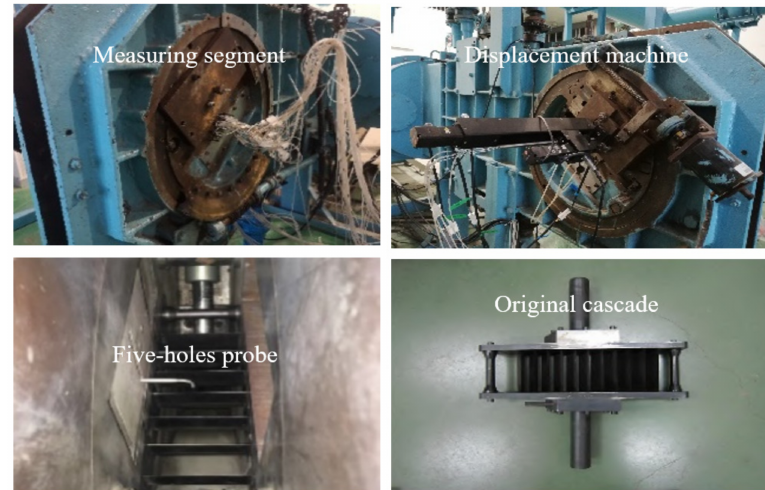
Figure 5. Some devices in the experiment of the original cascade.